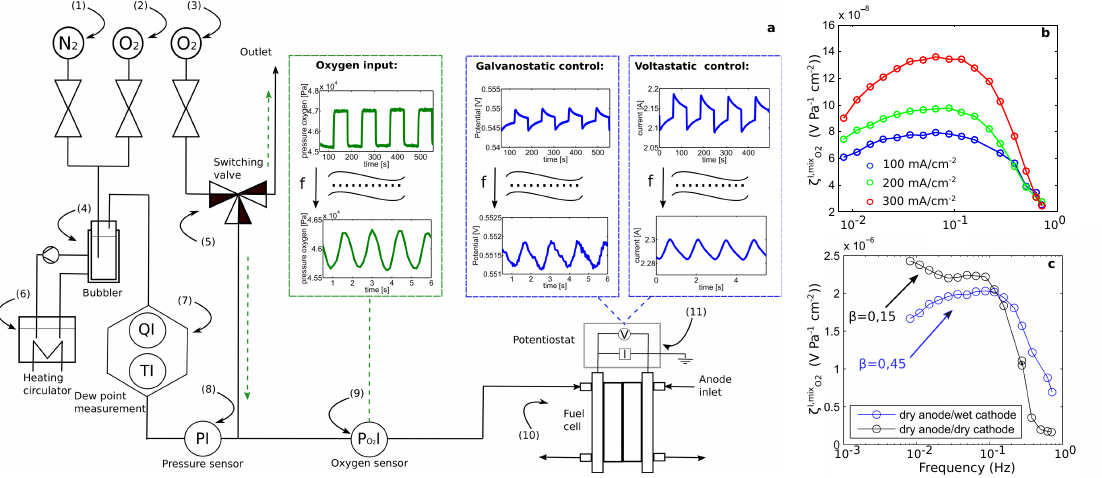
Figure 4. Concentration-alternating FRA (cFRA) technique: ( a ) Schematic of the cFRA experimental setup, ( b ) cFRA magnitude Bode plots of ζ I , mix at different polarization conditions, and ( c ) cFRA O 2 magnitude Bode plot of ζ I , mix at different relative humidity of the feeds. Figures adapted from O 2